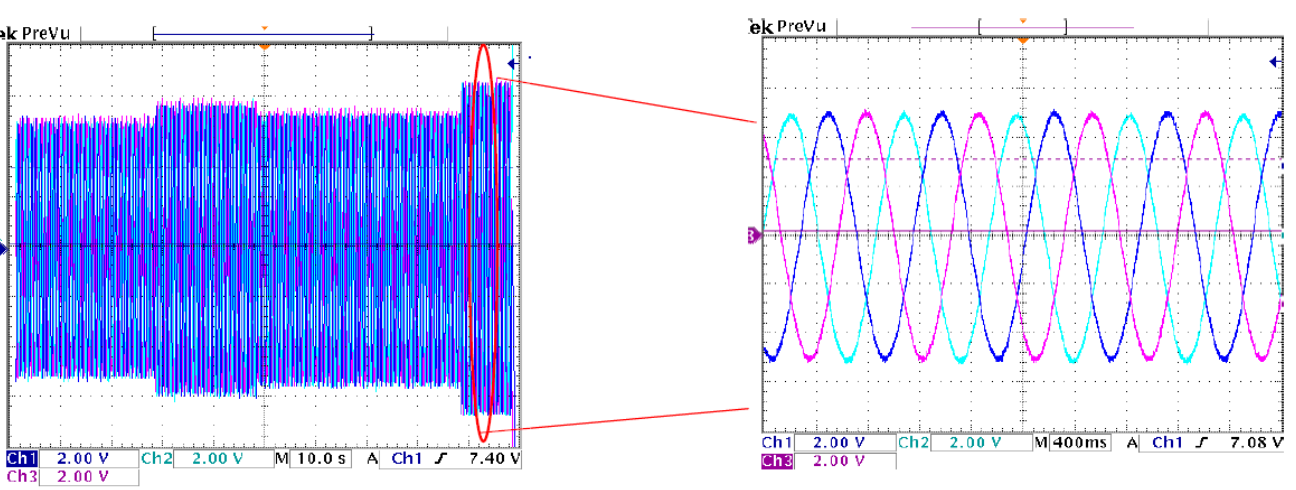
Figure 14. MLI signals.